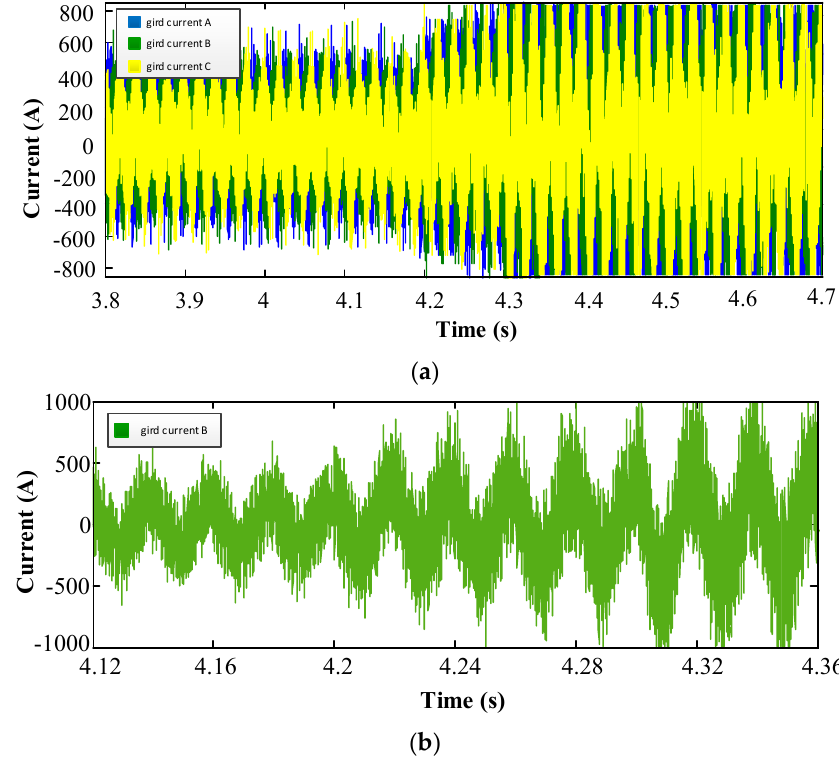
Figure 19. The simulated three-phase grid output currents of GSC in the stable case ( l L = 3.7 mH).